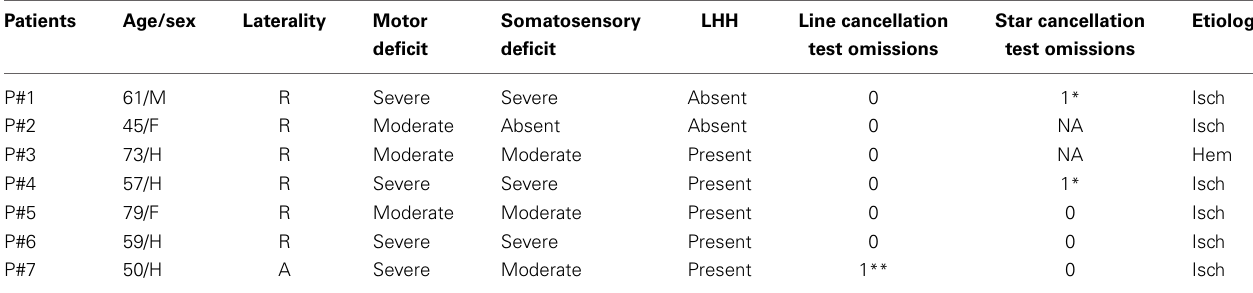
Table 1 | Demographical and neurological features of seven right brain-damaged patients. Patients Age/sex